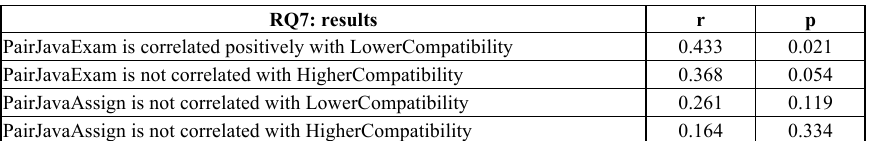
Results summary of RQ7